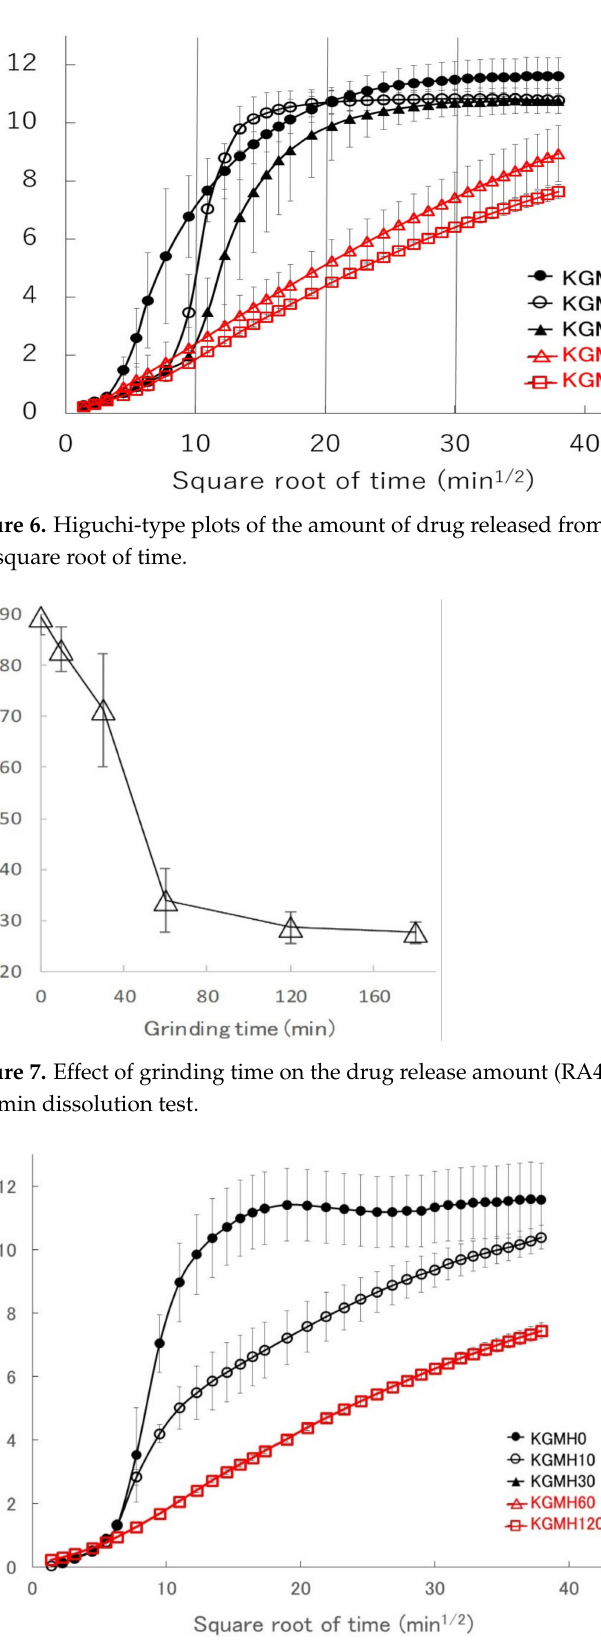
Figure 8. Effect of calcium hydroxide content on the drug release profiles of the KGML120, KGMM120, and KGMH120 matrix